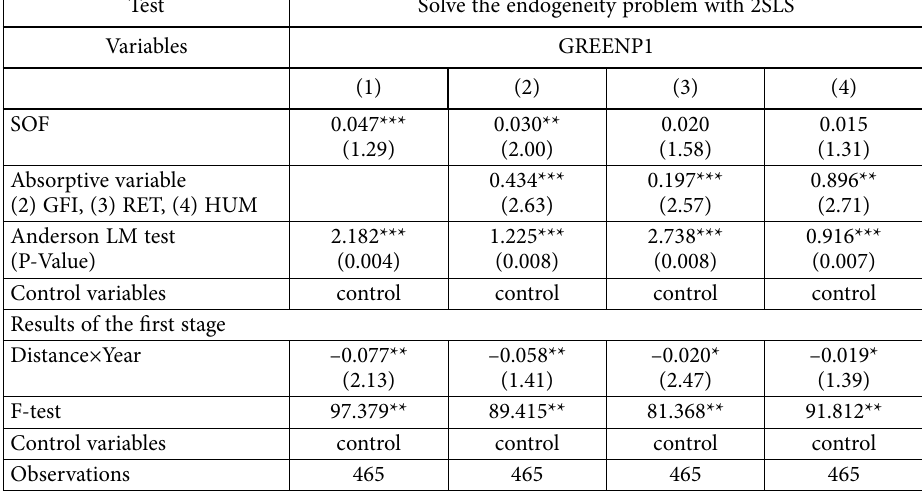
Table 5. Result of robustness